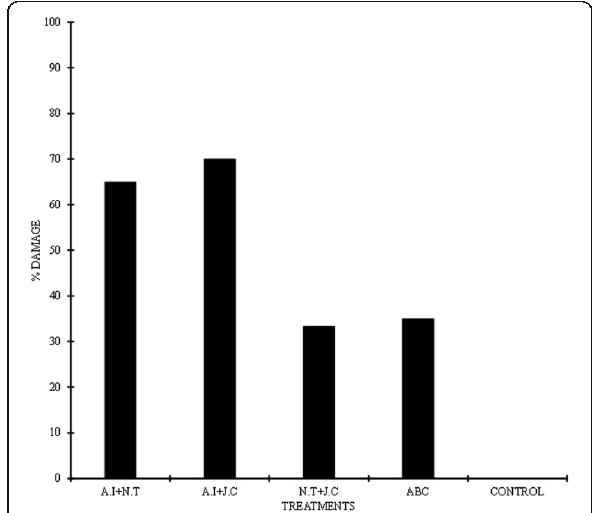
Fig. 6 Visual rating (%) of extract-treated wood exposed to Macrotermes subhyalinus under shade after 12 weeks. A.I+N.T = Azadirachta indica plus Nicotiana tabacum. J .C+A.I = Jatropha curcas plus Azadirachta indica. N .T+J.C = Nicotiana tabacum plus Jatropha curcas. A BC = Azadirachta indica plus Nicotiana tabacum plus Jatropha curcas